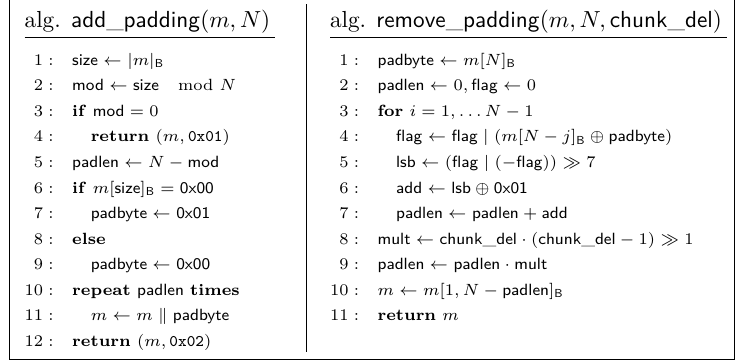
Figure 10: Functions to add byte-alternating padding and compute chunk delimiter, and to remove byte-alternating padding. The variable flag is to be interpreted as an unsigned 8-bit integer and − n is defined as the operation 2 8 − n . Beware that some systems/languages/compilers may not respect these